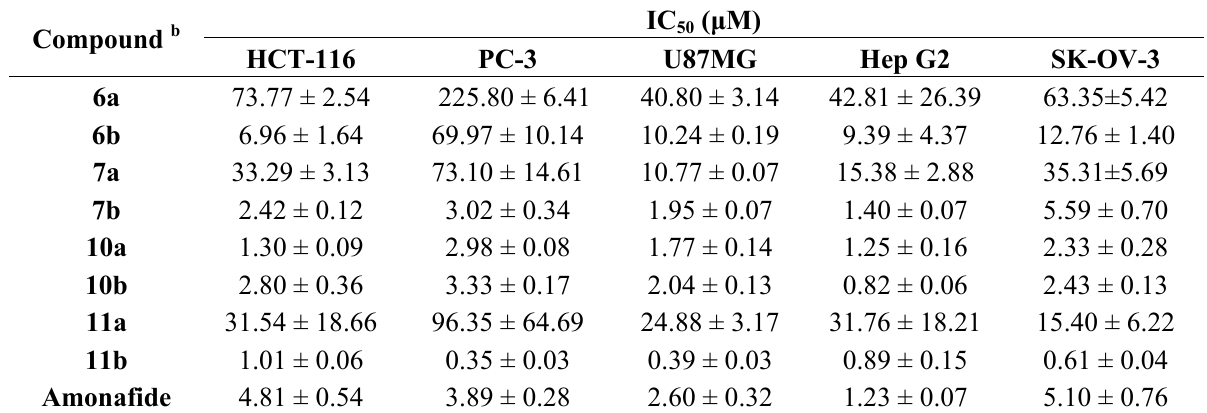
values of naphthalimide derivatives against five cancer cell lines a Table 1. IC 50